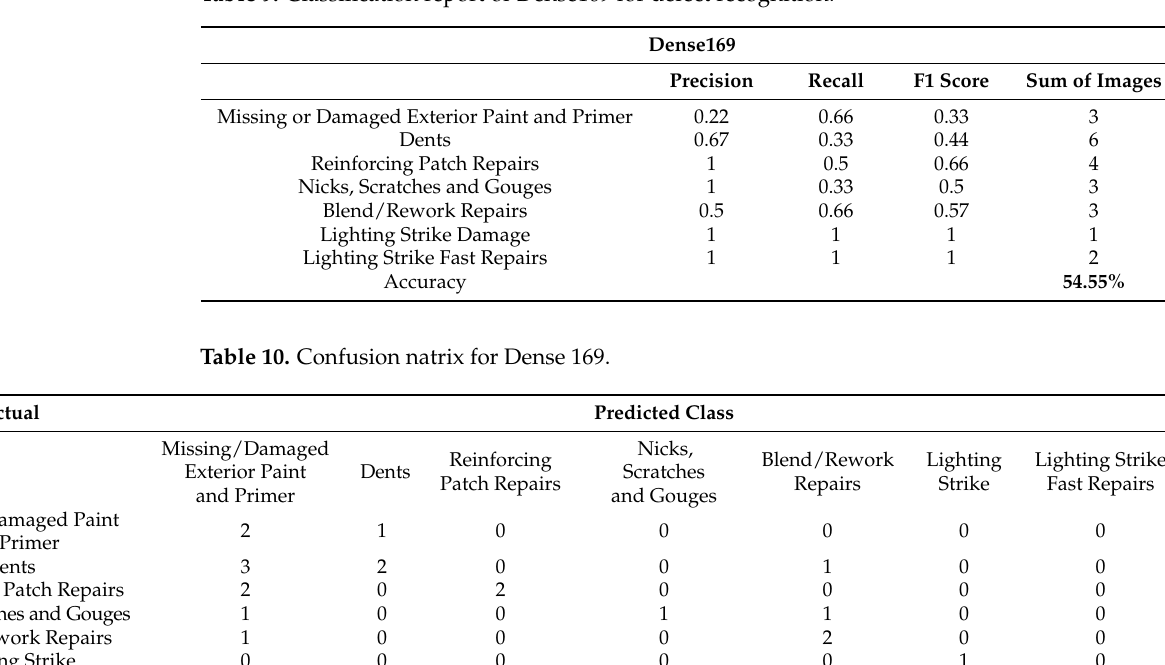
Table 9. Classification report of Dense169 for defect recognition.